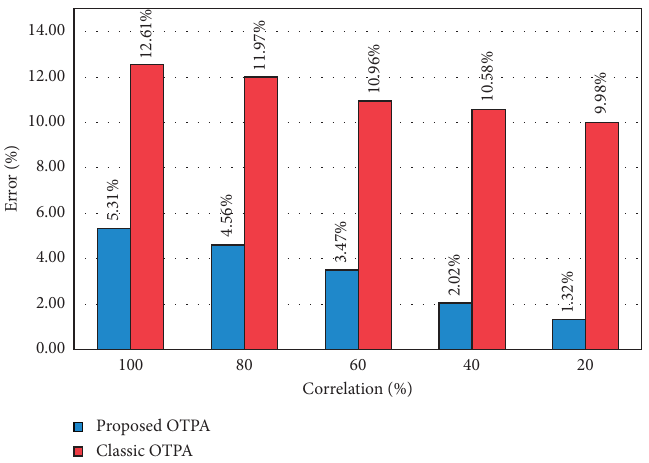
Figure 18: Errors of the proposed and classic OTPA in the response synthesis of the correlation Figure 23 details the position of the different receivers and the sources in the simulated environment, and the results are shown in Figure 24: the contribution of source A